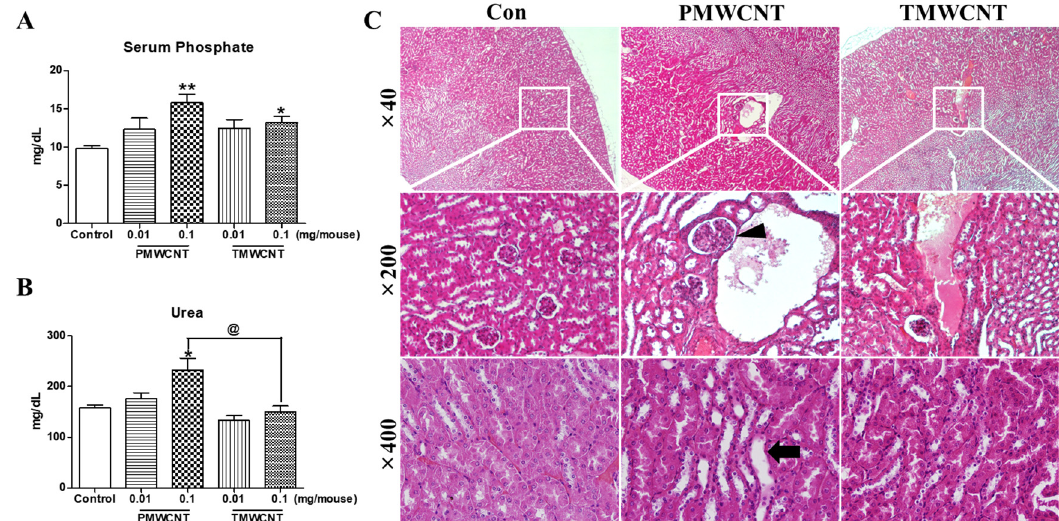
Figure 3. Alteration of serum phosphate, blood urea nitrogen level and kidney histology by MWCNTs after 6 months of instillation. ( A ) Serum phosphate level of mice and ( B ) Serum blood urea nitrogen level of mice after treatment with saline, PMWCNTs, and TMWCNTs. ( C ) H&E staining of sections of the cortex (×200) and medulla (×400) of the kidneys at 6 months post instillation of saline, PMWCNTs, and TMWCNTs. Arrows indicate increased interstitial volume in the PMWCNT-treated group. Arrow heads indicate increased glomerular size. Representative figures of five individuals from each group. Magnifications are indicated in the figures. Error bars indicate mean ± S.E.M. * p < 0.05 and ** p < 0.001 indicate statistical difference compared to the control group. @ p < 0.05 is statistical difference between 0.1 mg of PMWCNTs and TMWCNTs.